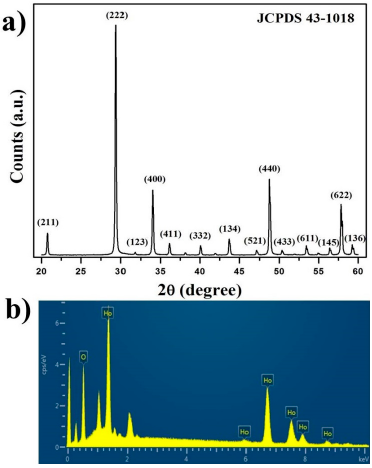
Figure 1. ( a ) X-ray diffraction (XRD) and ( b ) EDX analysis of as-prepared Ho 2 O 3 nanoparticles (NPs).